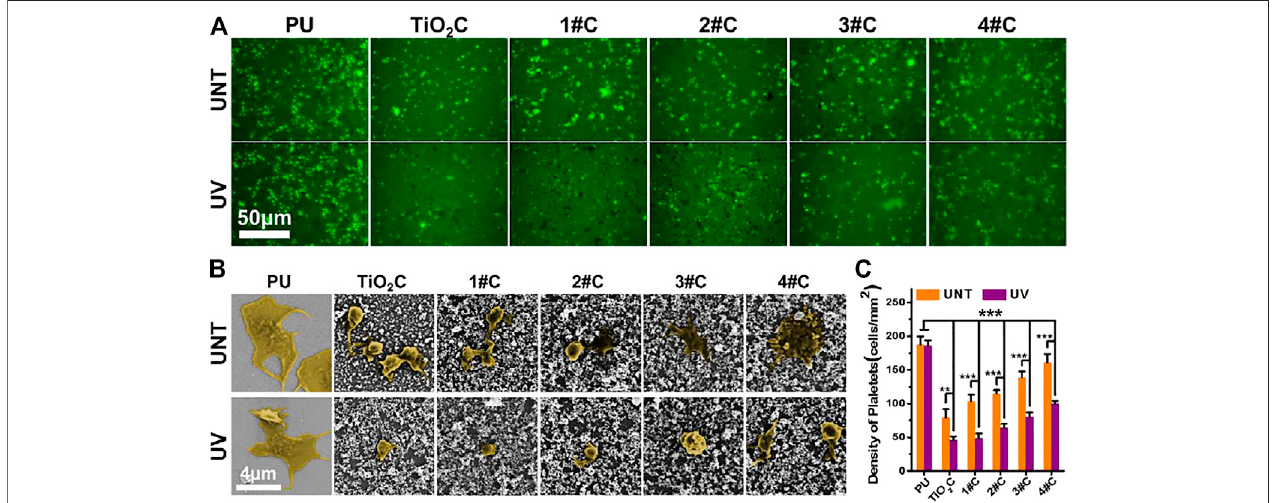
FIGURE 5 | Schematic diagram of the ex-vivo blood circulation experiment (A) ; photograph of the catheter after the experiment (B) ; the weight of the thrombus formed in the catheter (C) ; catheter occlusion rate (D) ; microscopic image of the catheter lining by SEM (E) .